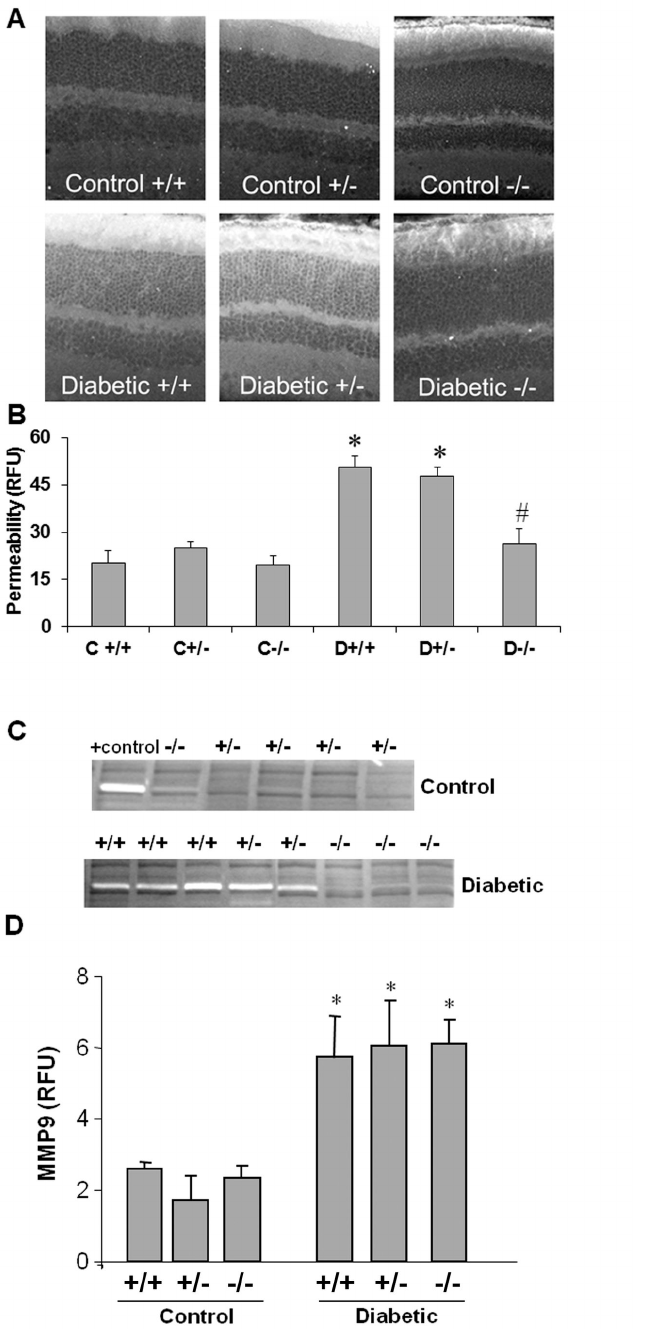
Figure 7. Blockade of diabetes-induced increase in retinal vascular permeability and MMP9 activity in uPAR-/- mice. Diabetic and non-diabetic uPAR-/- mice and their congenic controls (uPAR+/+, uPAR+/-) were injected intravenously with Alexa-Fluor 488-BSA (10 mg/kg) and permeability was quantified as described in the methods section. Permeability was significantly increased in the diabetic uPAR+/+ or uPAR+/- mice compared with the non-diabetic controls (A). Permeability was not increased in the uPAR-/- mice. n=4-6. C, control; D, diabetic; *, P <0.01 versus non-diabetic control; #, P <0.01 versus uPAR+/+ and uPAR+/- diabetic. Gelatin zymograms prepared using vitreous samples collected from the same mice showed prominent increases in MMP9 activity in the uPAR+/+ and uPAR+/- diabetic mice. MMP9 activity was absent in retinas from uPAR-/- diabetic mice and non-diabetic controls (B). Retinal sections from diabetic and control mice were immunolabeled with anti-phospho-GSK3β antibody (green) and Texas red-isolectin B4 (red) (C). This analysis showed that phospho-GSK3β co-localizes with the lectin-positive vessels in the diabetic retina (arrows) and is present in microglial-like cells (arrowheads) in both control and diabetic retinas. doi: 10.1371/journal.pone.0071868.g007 PLOS ONE |